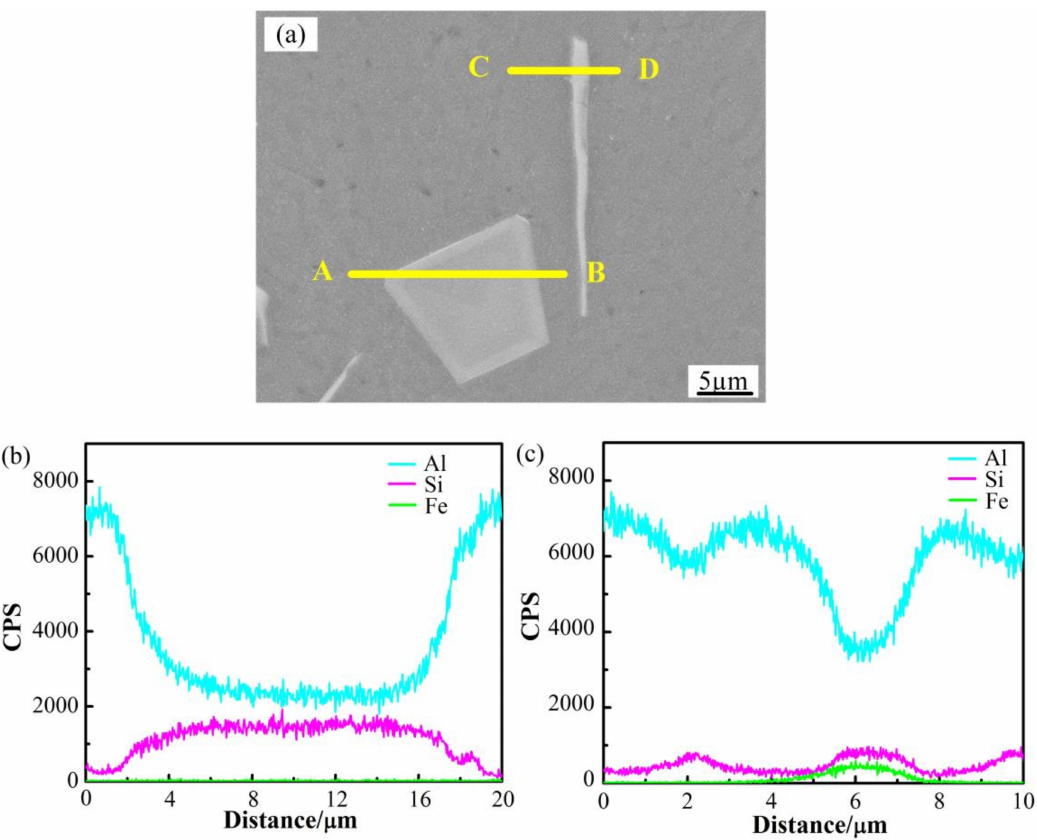
Figure 6. SEM micrographs and corresponding elemental distribution along lines in the cast Al 4047 samples: ( a ) SEM micrograph; ( b ) element distribution along line of AB in 6a; and ( c ) element distribution along line of CD in